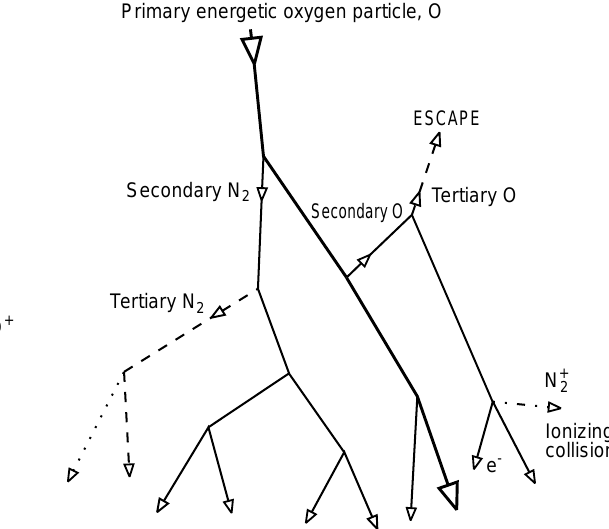
Fig. 2. Ionization production by neutralized ring current particles